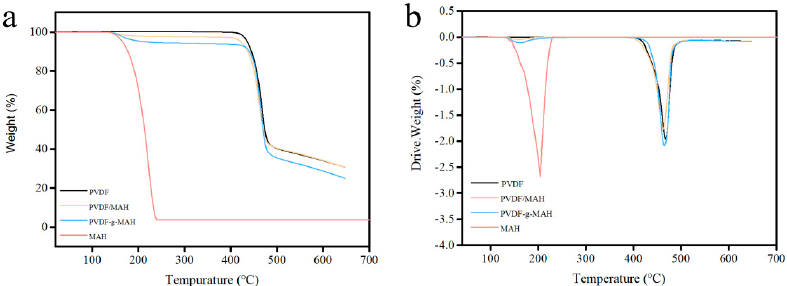
46.9 Figure 6. DSC curves of pure PVDF, PVDF/MAH and PVDF-g-MAH (G = 0.63%): ( a ), temperature rise curve; ( b ), cooling curve. 2.7. Thermal Stability As shown in Figure 7, the thermal stability of PVDF, PVDF/MAH and PVDF-g-MAH